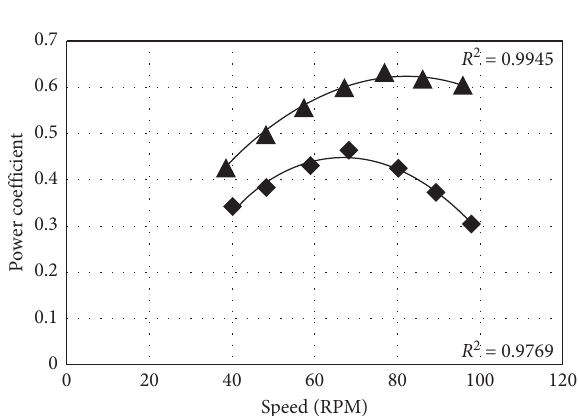
Figure 39: Runner 22 data points.